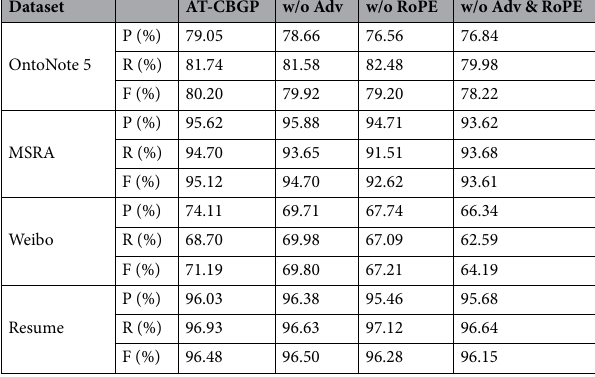
Table 5. Ablation experiments results on OntoNote 5, MSRA, Weibo and Resume dataset.